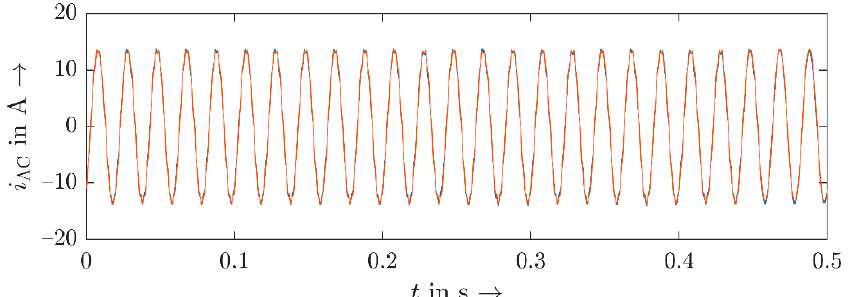
Figure 6. Measured grid-side current (red) and grid-side current simulated by ANN (blue) with a 500 Hz distortion component in u AC.